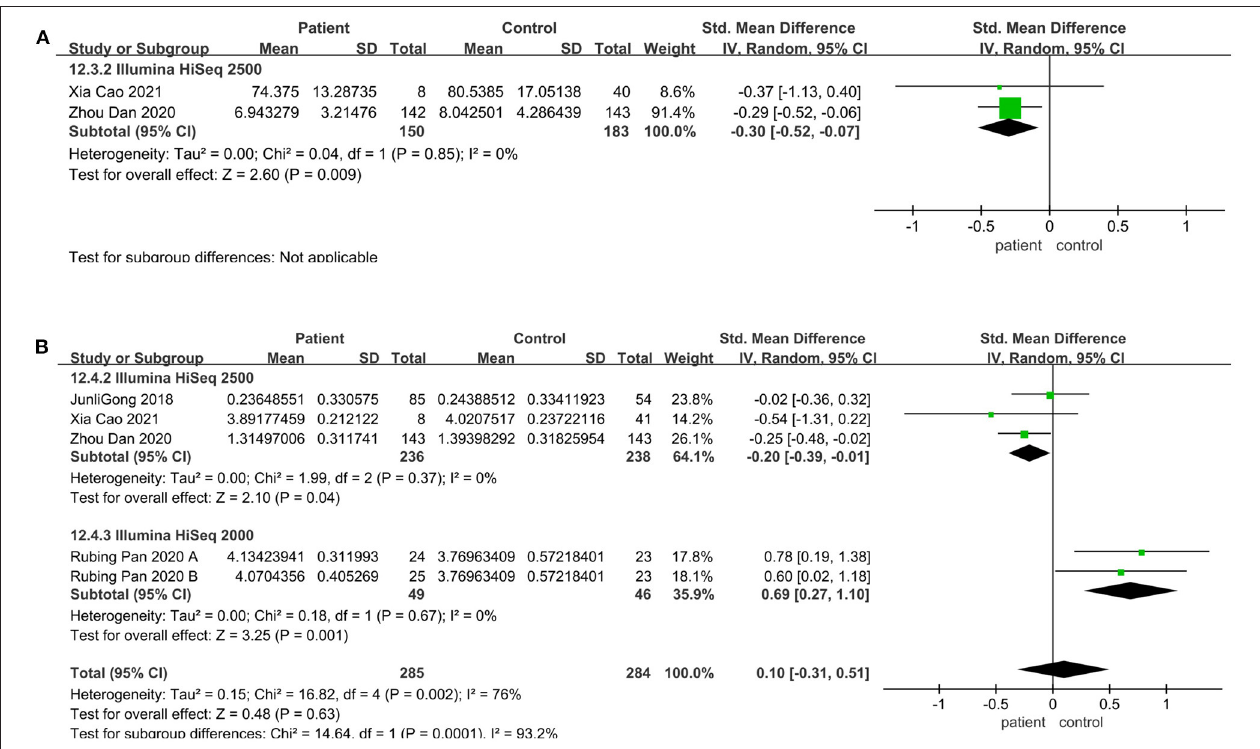
FIGURE 5 | Richness meta-analyses for the sequencing instrument. Forest plot for the ACE (A) and Shannon (B) . SMD, standardized mean difference; SD, standard